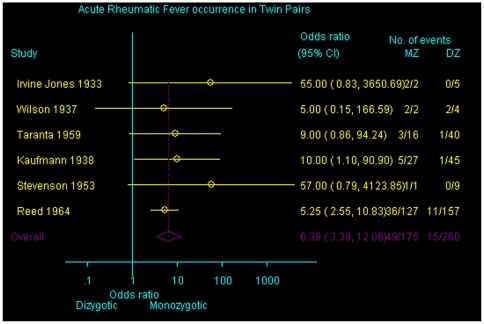
Odds ratio of concordance for acute rheumatic fever according to type of zygosity.Horizontal lines, 95% confidence interval; CI, Confidence interval; MZ, monozygotic; DZ, dizygotic.